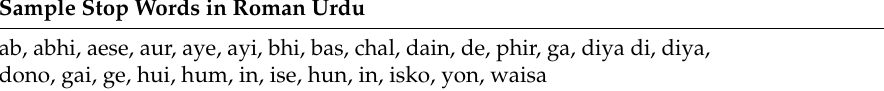
Sample Stop Words in Roman Urdu